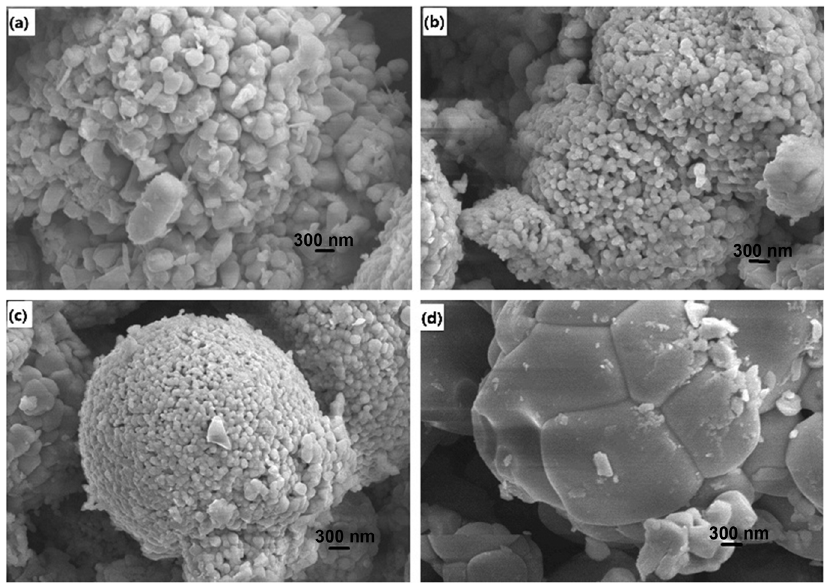
Figure 5: SEM pictures of BiVO 4 samples with different heat treatment time (a) 0.5 h, (b) 1 h, (c) 3 h, (d) 5 h.